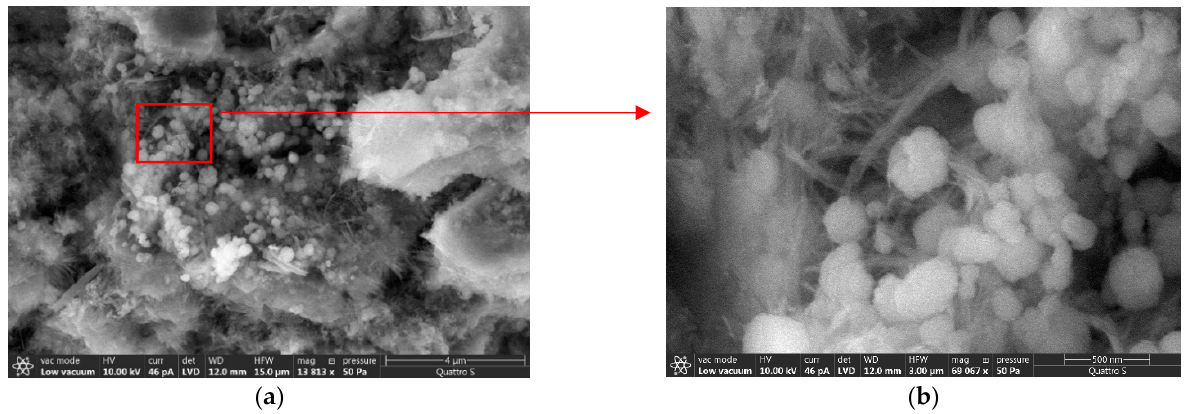
Figure 9. Microstructure of cement matrix modified with the complex additive: ( a ) at 14000-fold magnification; ( b ) a fragment at 70,000-fold magnification.